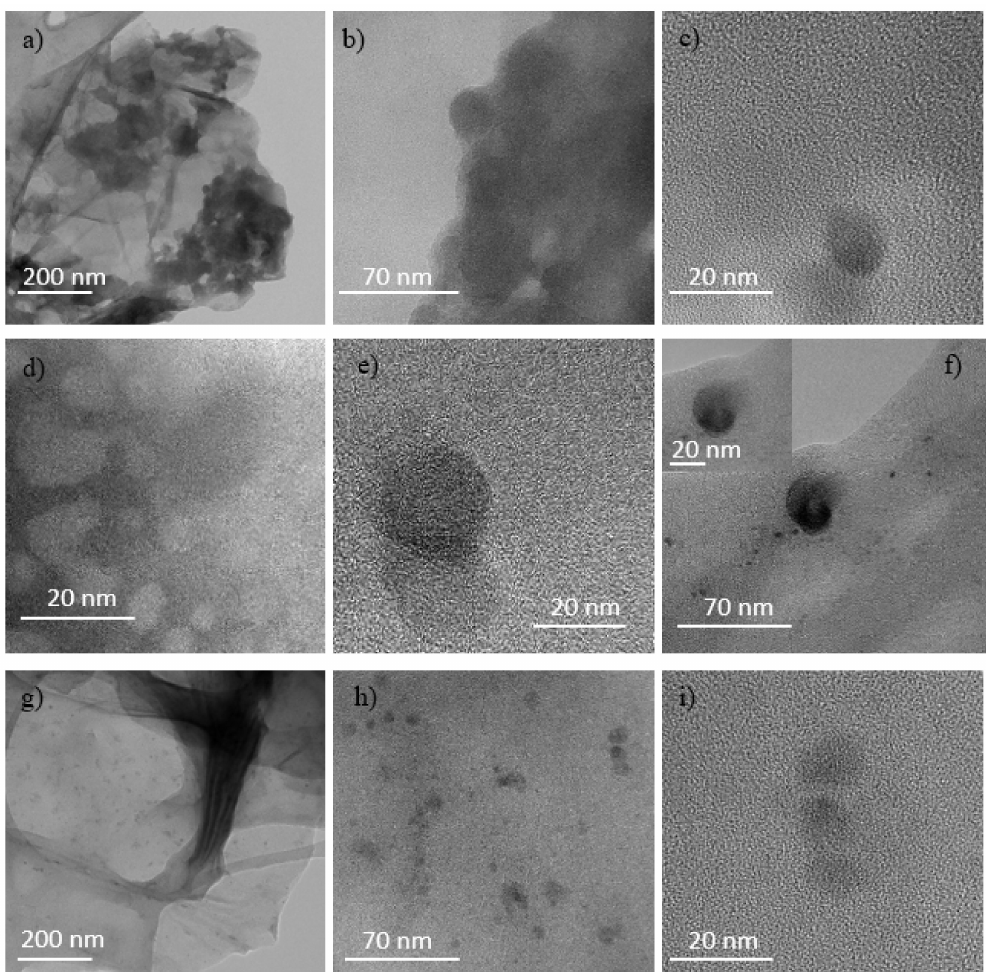
Figure 12. TEM micrograph of GO irradiated by the 3 MeV O + ions at the 5 × 10 11 ions/cm 2 ( a – c ), 5 × 10 12 ions/cm 2 ( d – f ) and 5 × 10 13 ions/cm 2 ( g – i )